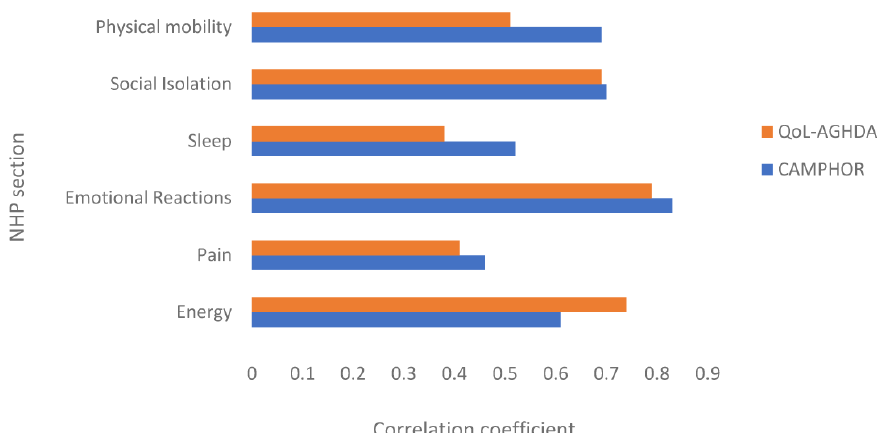
Figure 1. Spearman’s rank correlation coefficients between NHP section scores and total scores on the QoL-AGHDA and CAMPHOR QoL scale. Note: All correlations were significant at